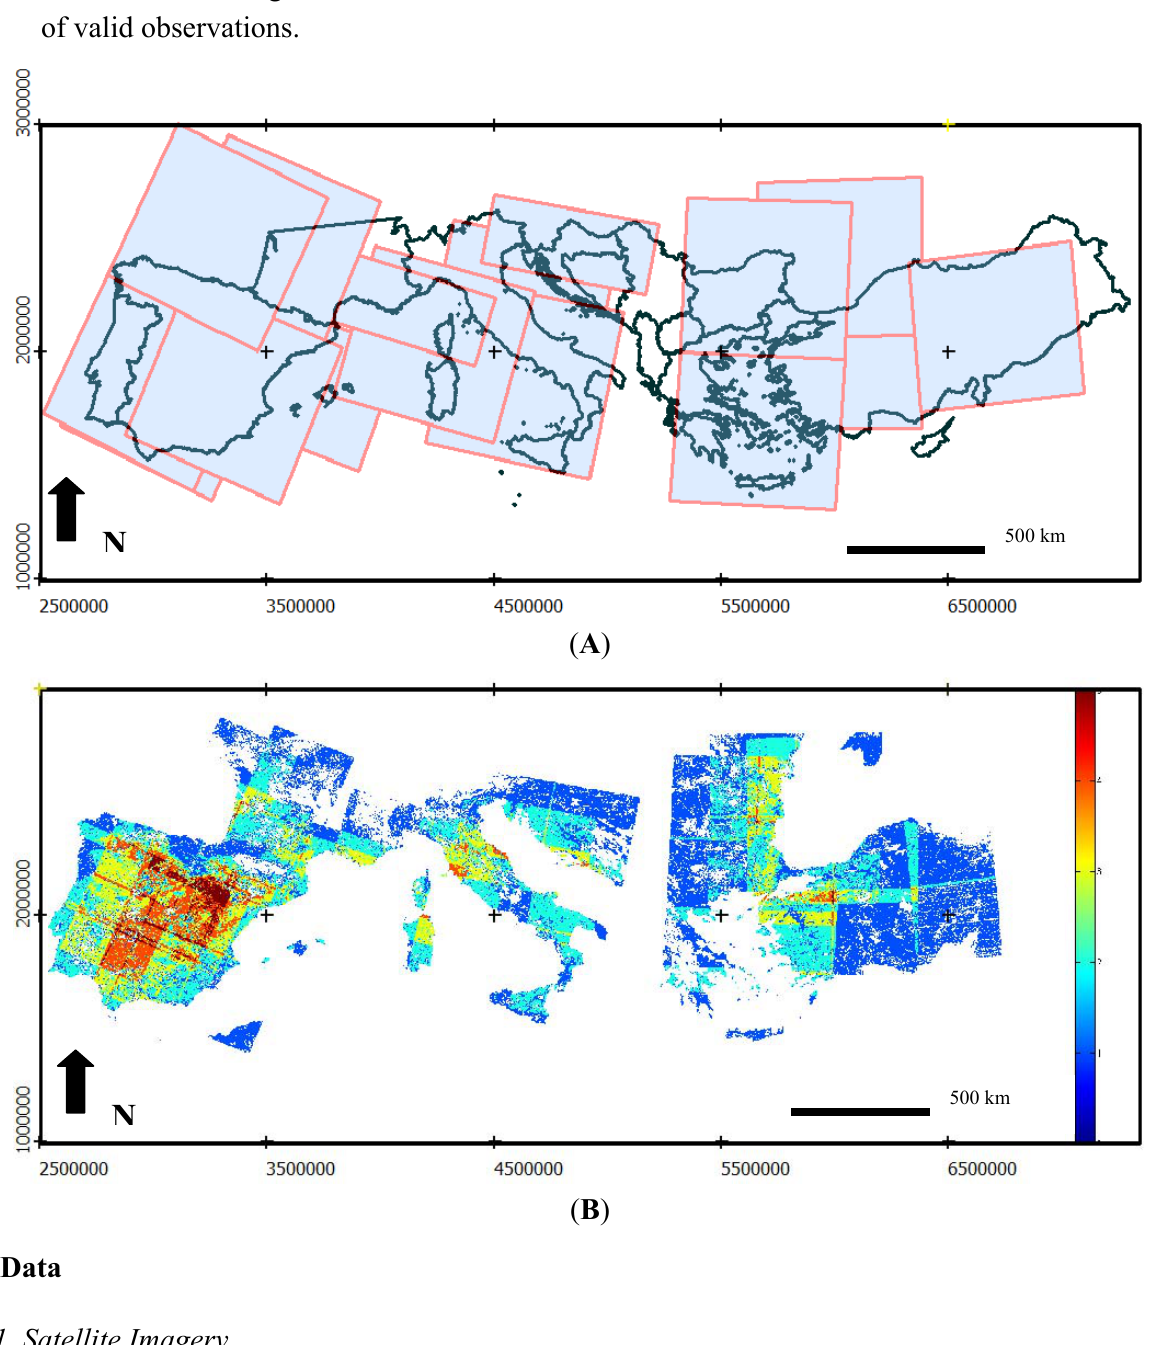
Figure 1. ( A ) Location map (ETRS89/LAEA projection) and coverage of the 61 IRS-AWiFS scene dataset. ( B ) Number of valid observations after applying cloud and cloud shadow, slope and water masks. The color scale represents the number of valid observations. Red tones indicate a large number of valid observations while blue tones indicate a low number of valid